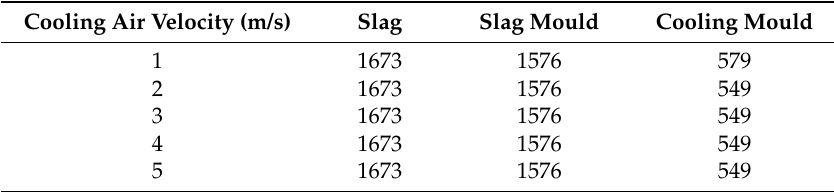
Table 5. Maximum temperature ( ◦ K) of drum elements for each cooling air velocity considered (glass